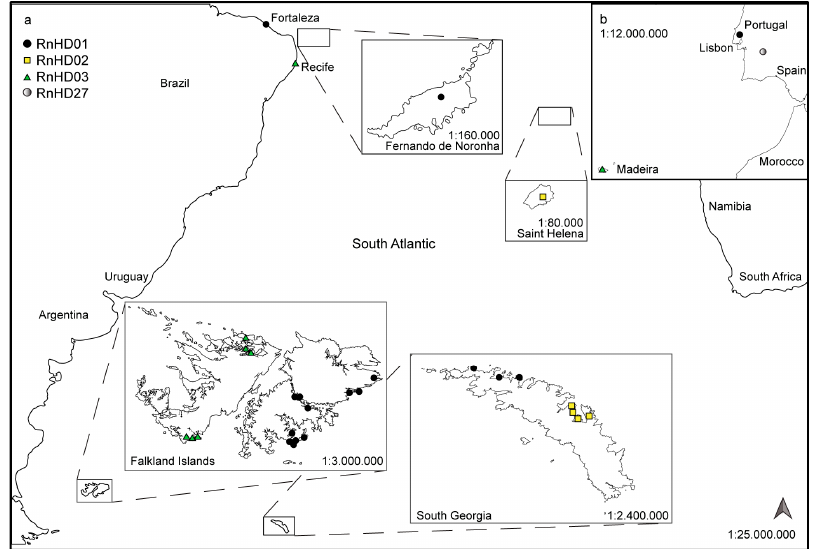
Figure 1. Map showing the sampling sites ( a ) within the South Atlantic Ocean. Areas of interest are magnified; ( b ) Inset covering sampling sites in Southern Portugal and Madeira. Colour codes for haplotypes of R. norvegicus are presented in ( a ). Both maps adapted after Esri, DeLorme, HERE and MapmyIndia. Additional sites were sampled from existing databases (not shown).